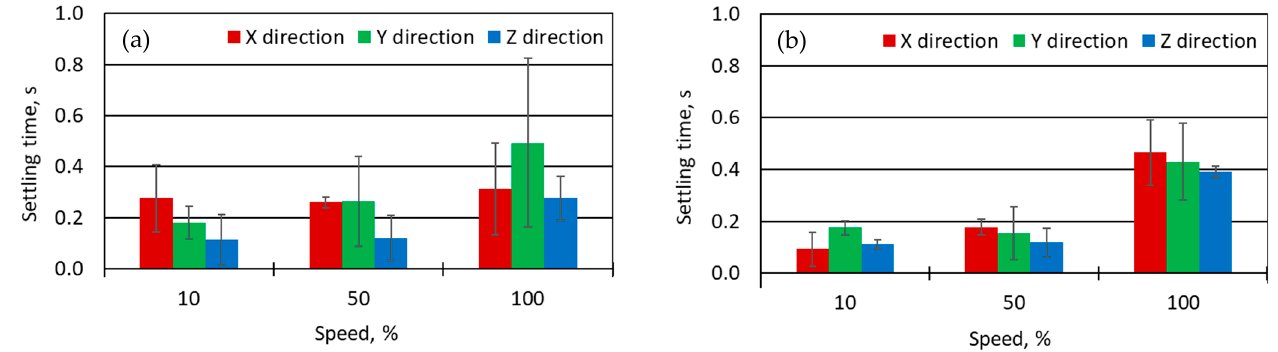
Figure 11. Settling time: ( a ) at the start (measuring) position (Figure 3a) and ( b )—at the endpoint of the trajectory (Figure 3b). Statistical evaluation processed according to Equations (8)–(13).